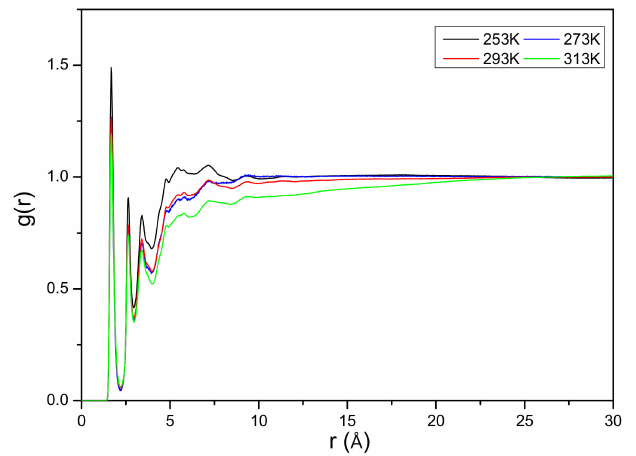
Figure 5. Radial distribution functions for cellulose around O atoms of OAc in different temperatures (80 wt%